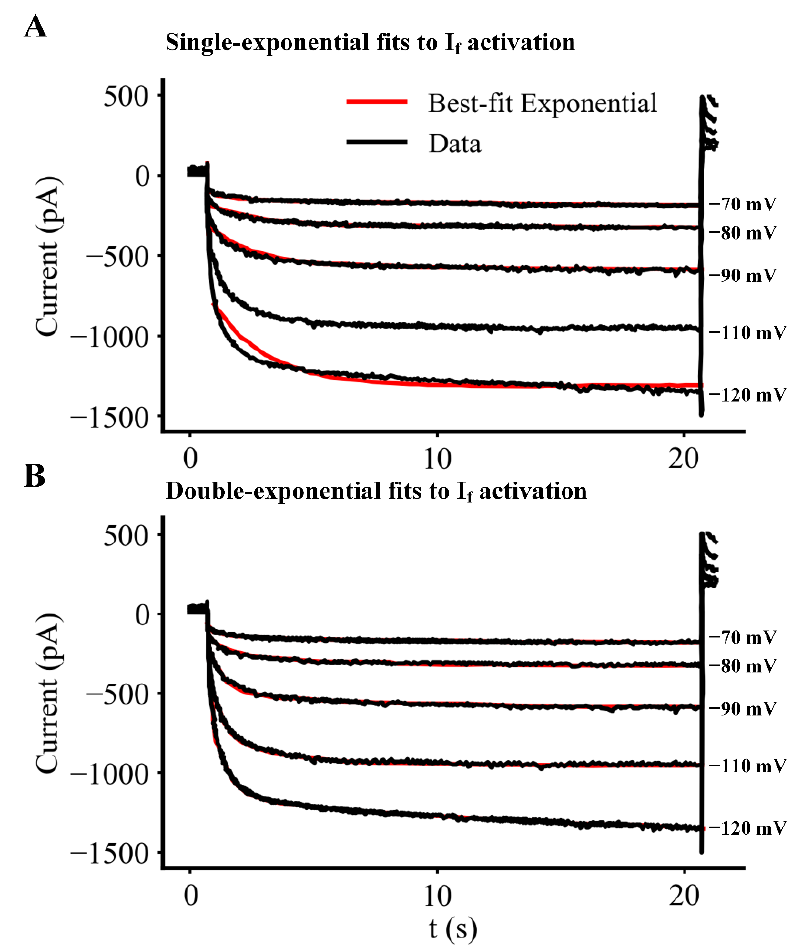
10 s voltage steps to membrane potentials in the range − 50 to − 110 mV. In each panel of Figure 5, red curve-fitted relationships have been superimposed on the black original current change records. In Figure 5A, a single exponential function was used in an attempt to fit these I f activation traces; in contrast, in Figure 5B the double exponential function provided below was used. It is apparent that the double exponential function provides a much better fit.